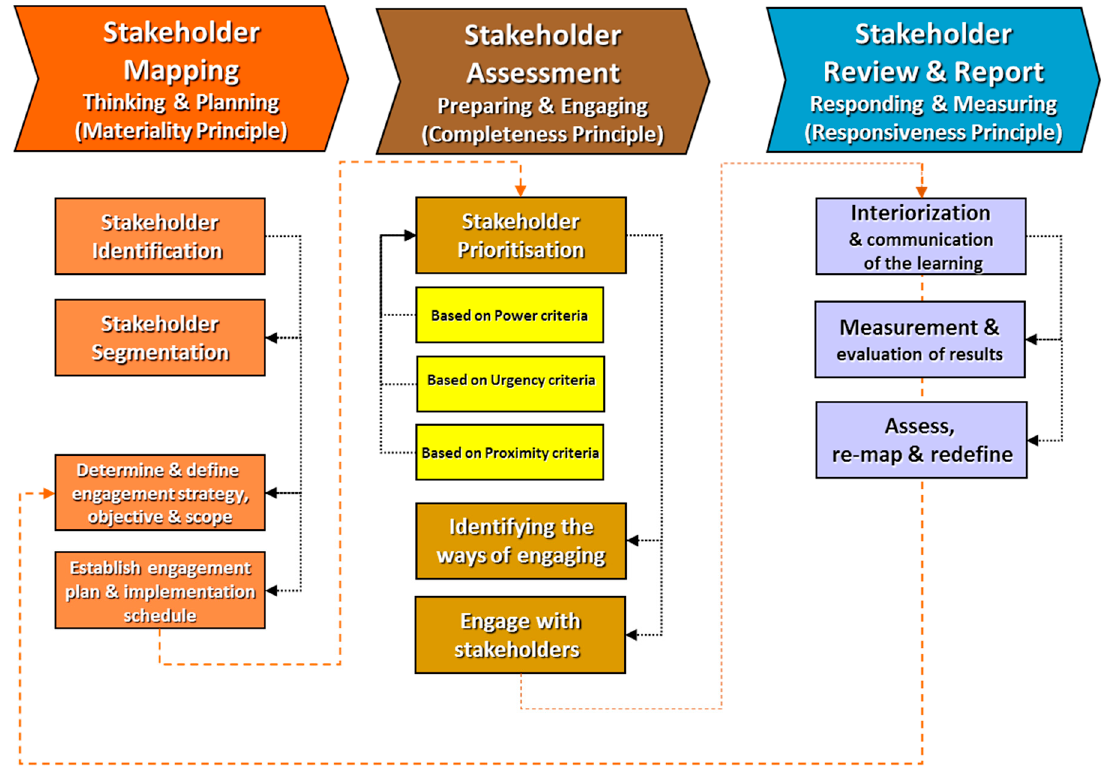
Figure 6. Stakeholder Engagement process phases (own elaboration based on the AA1000 standard).